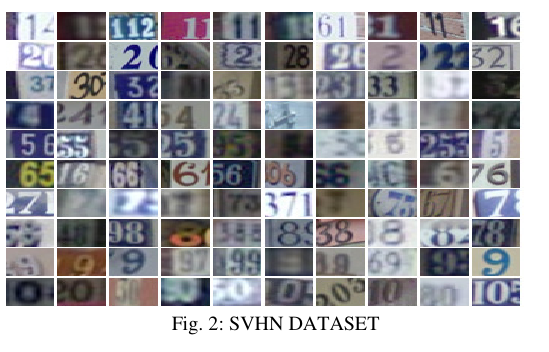
Fig. 2: SVHN DATASET